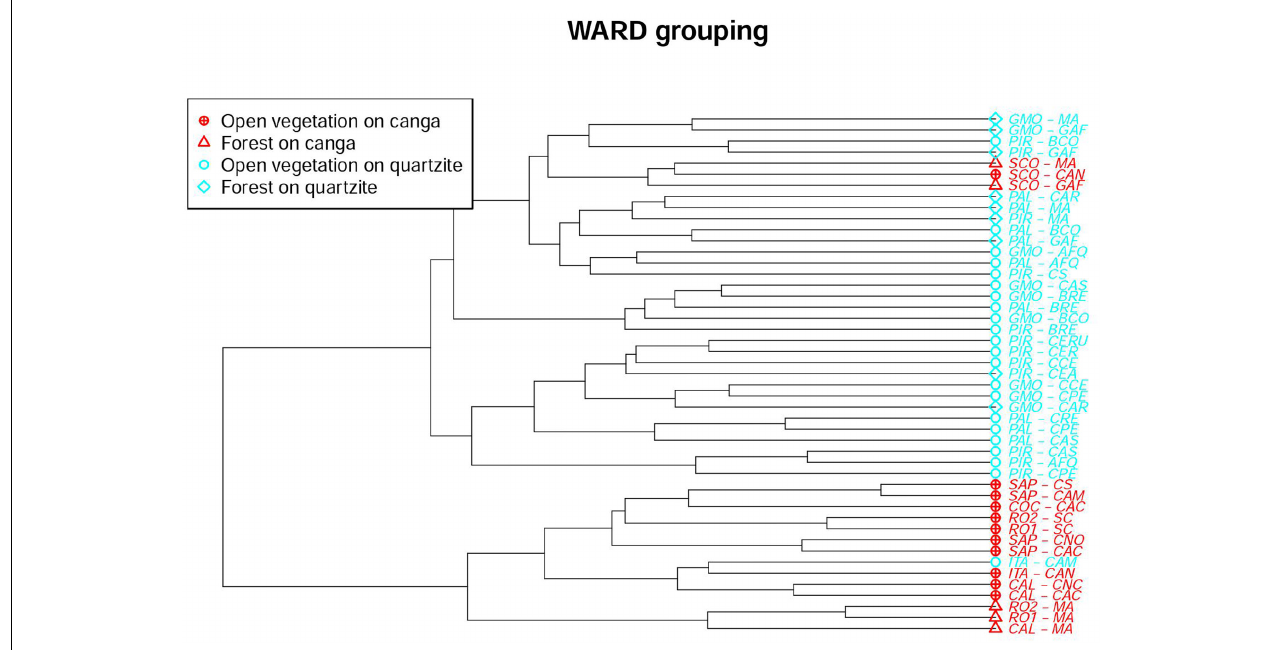
FIGURE 4 | Dendrogram showing results of Ward hierarchical clustering of 47 sites in the Espinhaço range.